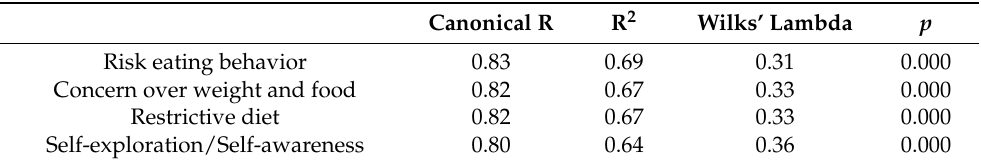
Table 2. Canonical correlation values, proportions of explained and unexplained variance, and significance ( p ).